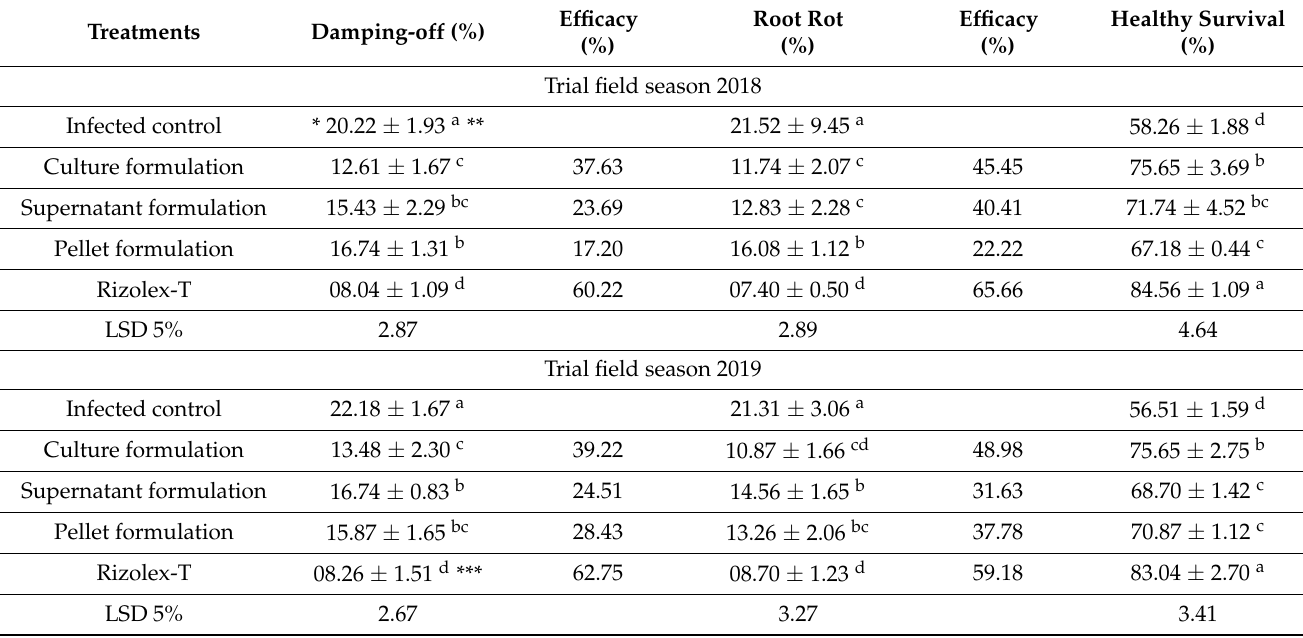
Table 5. Effect of treatment with talc-based formulations of Streptomyces cellulosae Actino 48 on peanut damping-off and root rot diseases incidence (%) under open-field conditions, during 2018 and 2019 seasons.